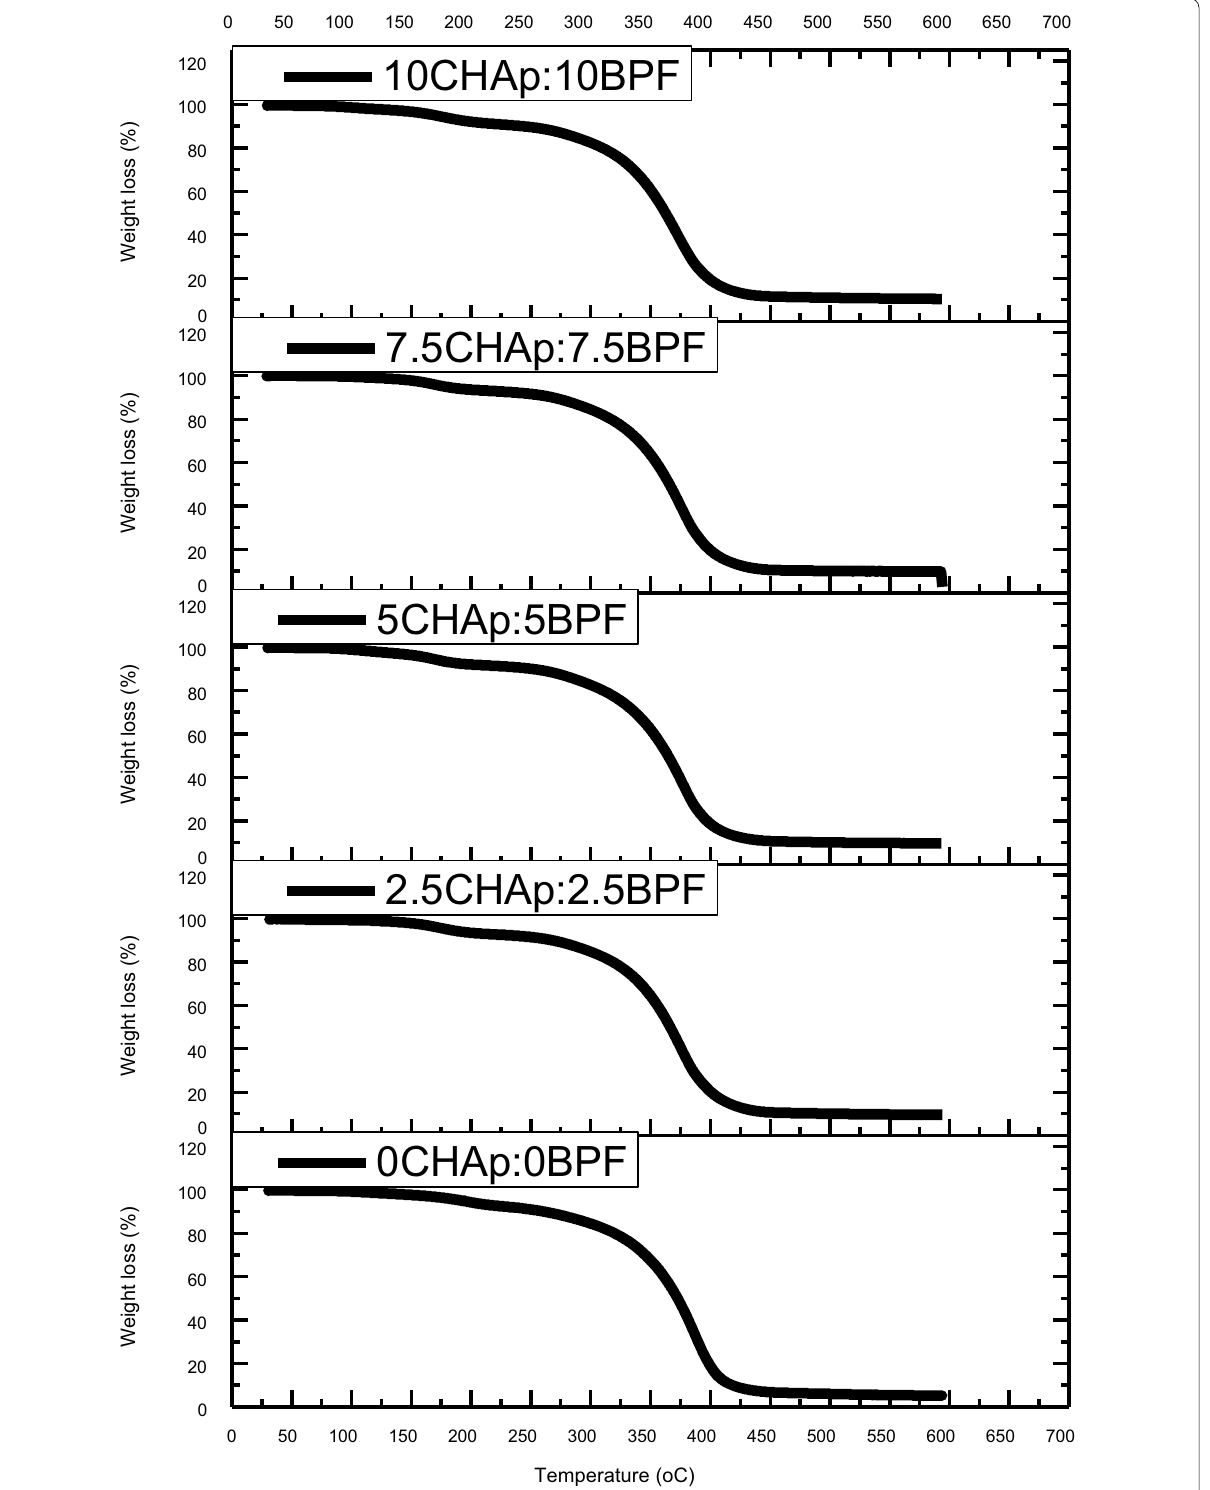
Fig. 9 Variation of percentage weight loss with temperature for composite produced with CHAp and